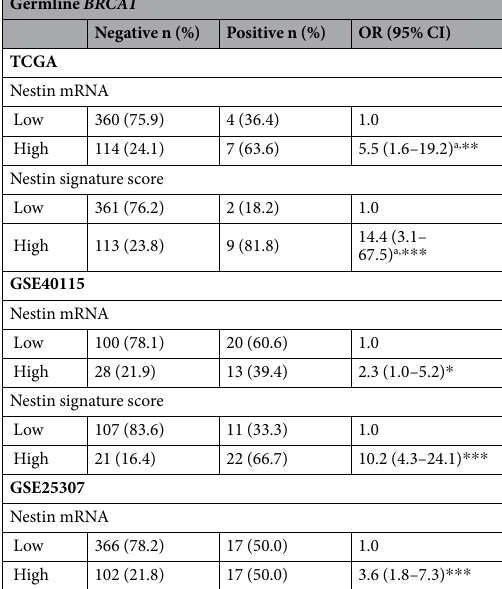
In the TCGA (The Cancer Genome Atlas) dataset, high Nestin mRNA ( NES ) and high Nestin signature score (by upper quartile) were associated with BRCA1 germline mutations (OR 5.5 and 14.4, respectively) (Table 4). Similar findings were observed in two BRCA -validation datasets (GSE25307 and GSE40115, OR range 2.3 to 10.2 for Nestin mRNA and signature score). Also, Nestin mRNA and signature score significantly predicted BRCA1 germline mutation status when analysed as continuous variables in all three gene expression cohorts (not shown). The Nestin mRNA signature score was the only significant predictor of BRCA1 germline mutations (OR 1.03, p = 0.001) when included together with EGFR, CK5, and P-cadherin by multiple logistic regression. When including TNP and the basal-like subgroup (by PAM50), only Nestin mRNA signature score sig- nificantly predicted BRCA1 germline mutation status (TCGA dataset, OR 1.03, p = 0.044), whereas the TNP, basal-like subgroup, CK5, EGFR, and P-cadherin did not. In the TCGA proteomic dataset (n = 103), all 3 patients with BRCA1 germline mutations had high Nestin pro-